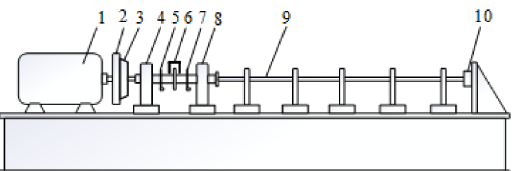
1 Driving unit, 2 Rotational speed, contact force, friction surface temperature sensor, 3 Clutch, 4 Bearing seat, 5 Torsional damper, 6 Additional damper, 7 Angle acceleration (receiver), 8 Bearing seat, 9 Torsion bar, 10 Torque measurement shaft